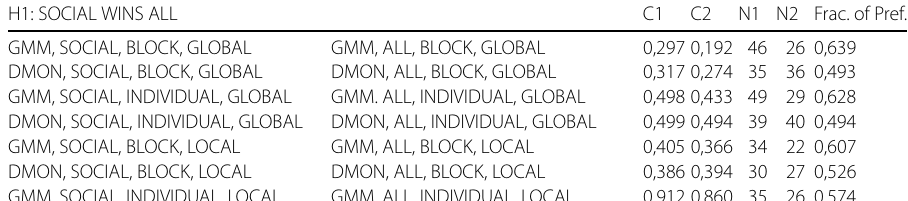
Table 6 Compactness of the maps used in our study. A higher value indicates a solution with more compact clusters. C1 and C2 show the indices for the first and second map, respectively H1: SOCIAL WINS ALL C1 C2 N1 N2 Frac. of